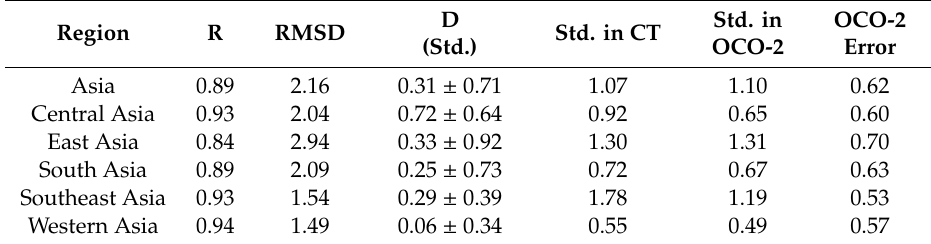
Table 3. The table shows the statistical relationship between the CT and OCO-2. The statistical parameters shown in the table are, the mean correlation coe ffi cient (R), an average of the root mean square derivation, the di ff erence between the CT and OCO-2 (D) with the standard deviation, the standard deviation in CT, the standard deviation in OCO-2 and OCO-2 error. The total number of datasets used in the analysis are 20,574,385 over 519 points distributed uniformly over Asia. Std. in CT R (Std.)